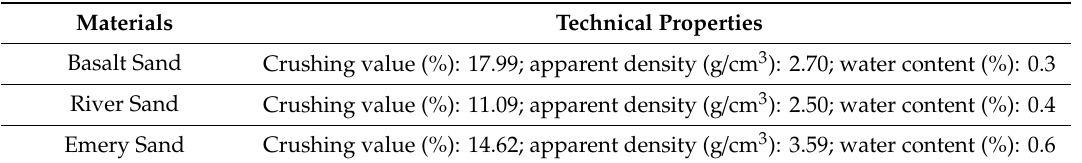
Table 2. Technical properties of skid resistance particles.